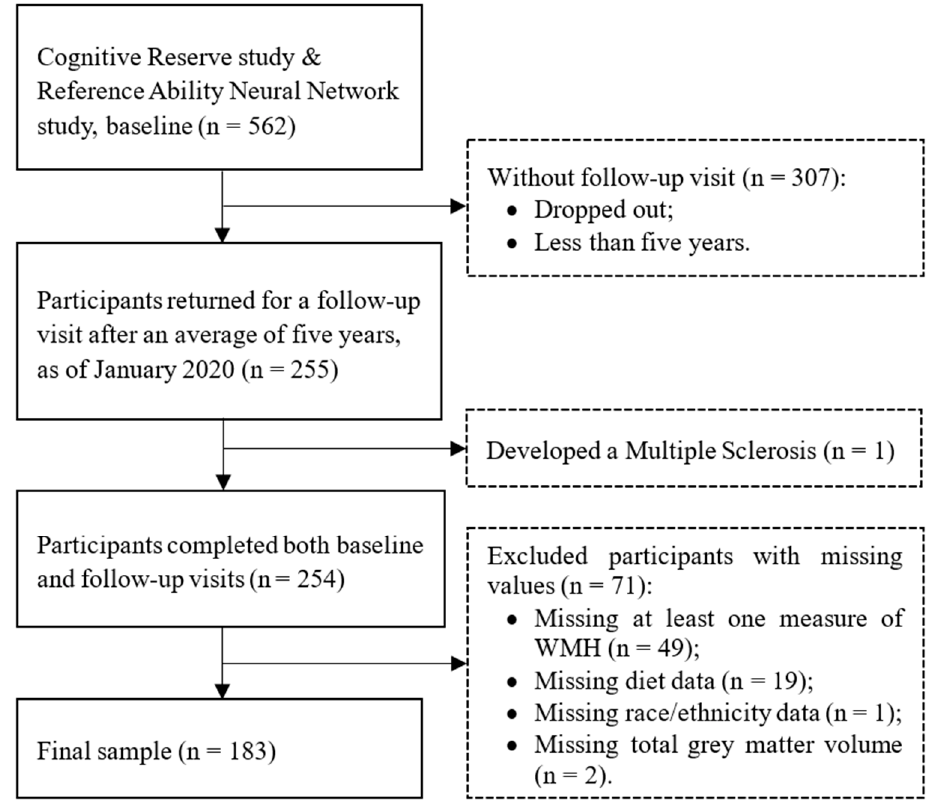
Figure 1. Flow chart of participant selection.